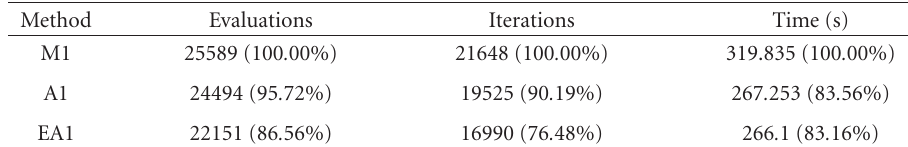
Table 4 . 2 . Results for dimensions from 2 to 15 (440 problems).